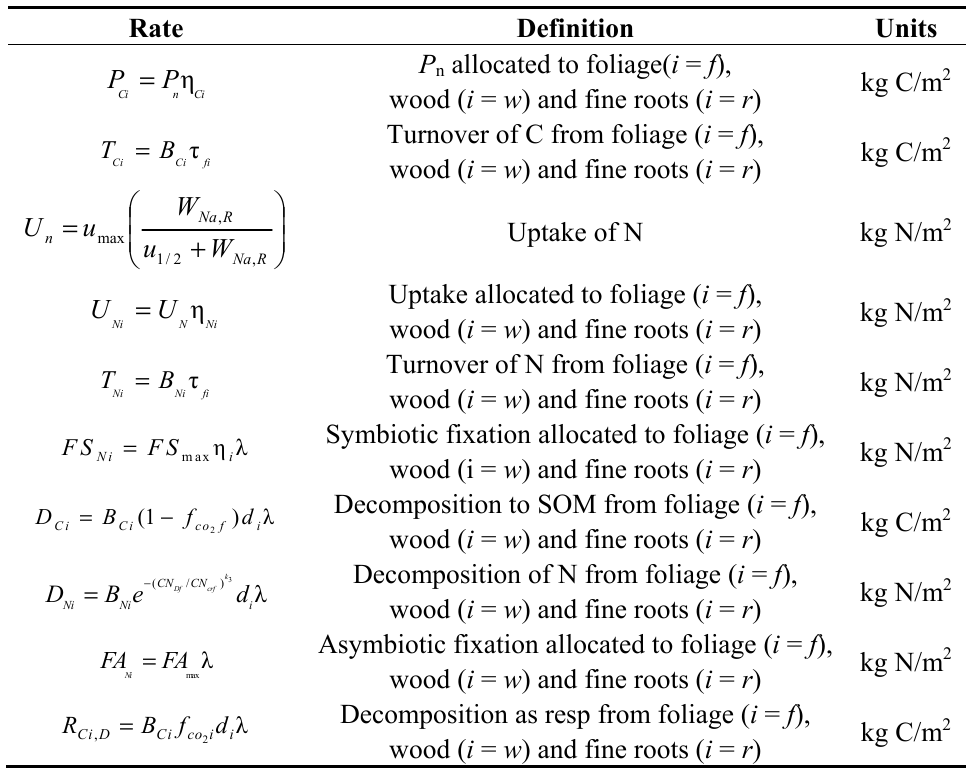
Table 4. Rate terms comprising vegetation mass balance equations. See Table 7 for definitions of parameter values.